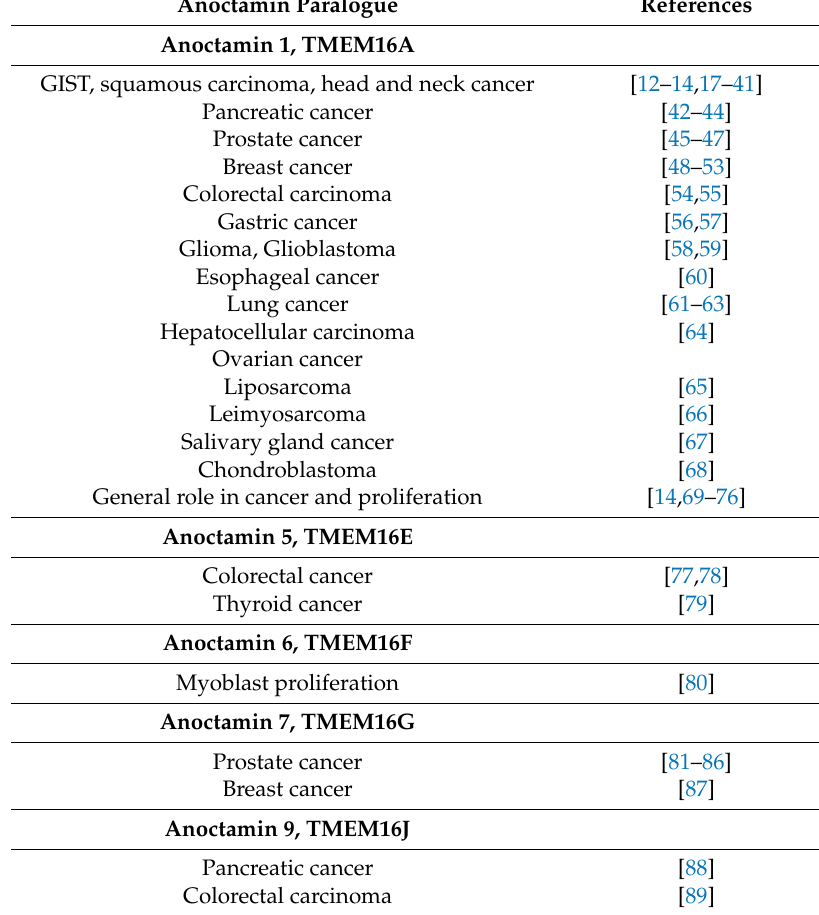
Table 1. Anoctamins in Cancer and